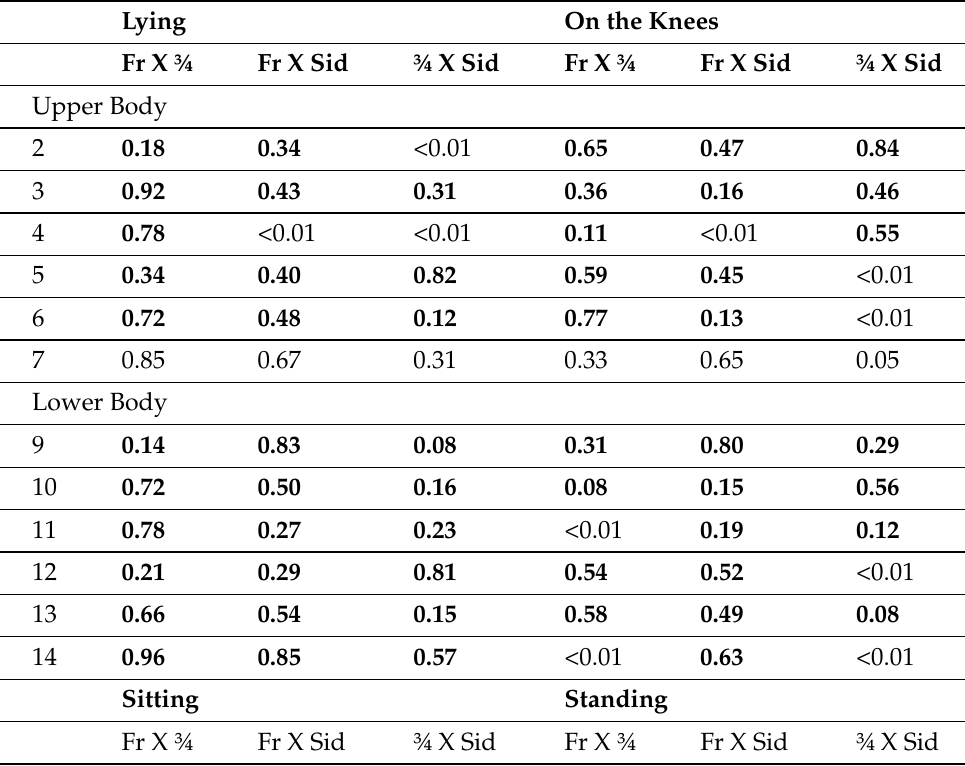
Table A2. Starting position, p -values of comparison of starting positions. Fr—front view; Sid—side view; ¾—¾